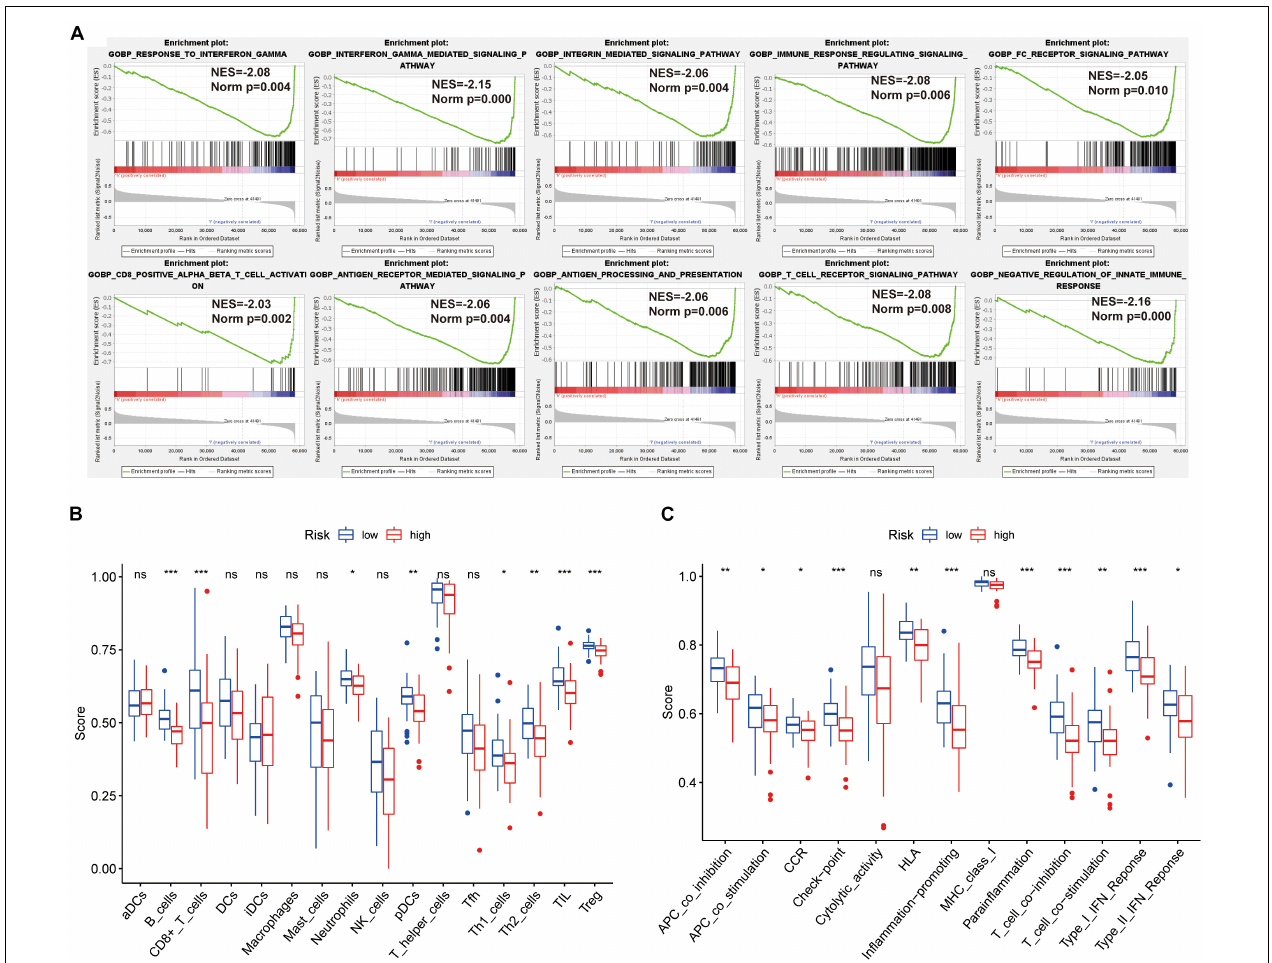
FIGURE 3 | GSEA of osteosarcoma patients based on the autophagy-related lncRNA prognostic signature. (A) GSEA results show significant enrichment of immune- and autophagy-related biological process in the low-risk patients. (B,C) Relationship between riskscore and immune cell infiltration and related functions via ssGSEA analysis. The score refers to the immune score, the higher the score, and the deeper the degree of immune cell infiltration. * P < 0.05, ** P < 0.01, and *** P < 0.001.